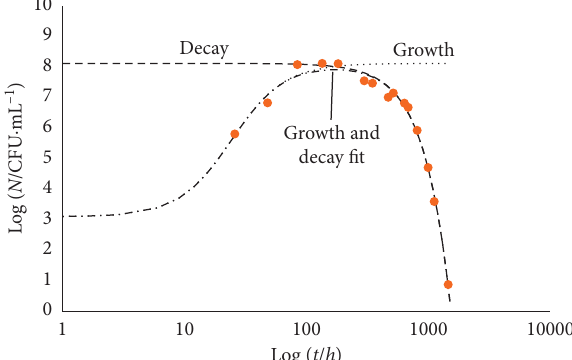
Figure 8: Growth and decay trend of Salmonella in broth. The experimental data come from the COMBASE data bank (Com Base ID: B10_1). The fitting curves correspond to equation (11). Log 10 ( N max /CFU · mL − 1 ) � 8.12, c � 589 h 2 , b � 0.06, d � 1.2510 5 h 2 , and δ � 2. Because of the large time span covered by the data, the variable t is in log 10 scale.